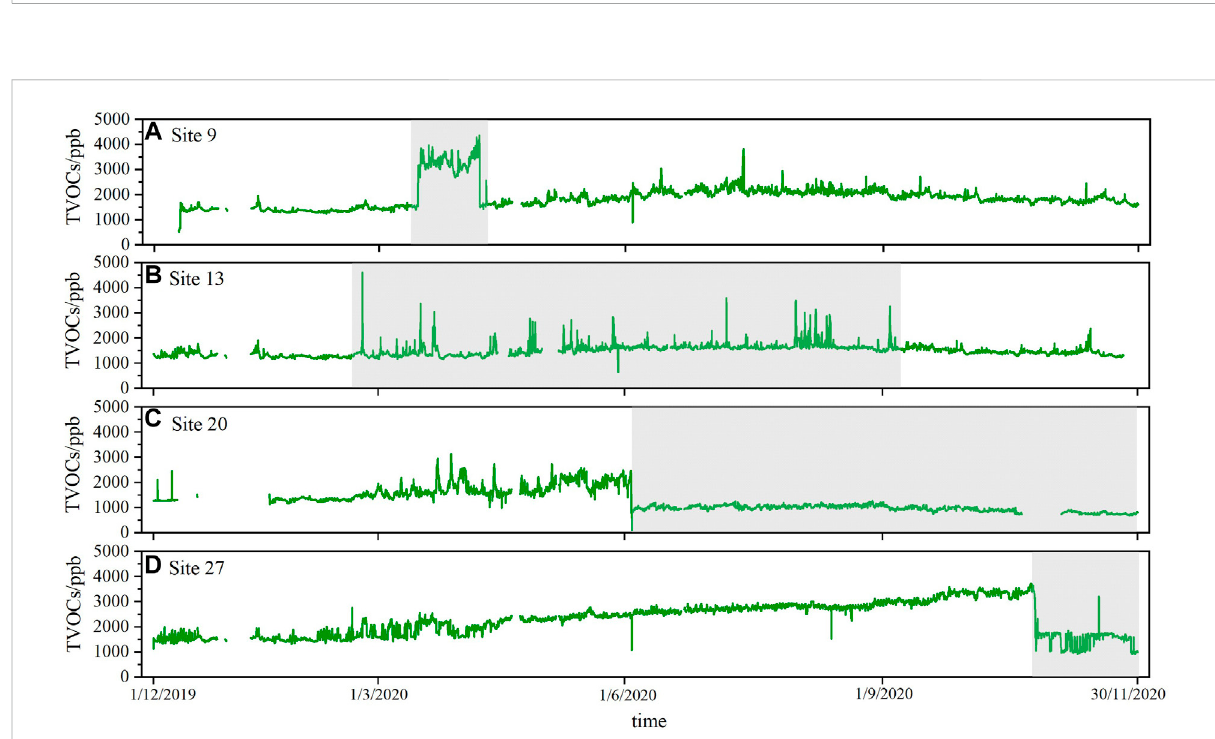
FIGURE 4 Temporalvariation of TVOCs atmonitoring stations ofsite 9 (A) ,site 13 (B) , site20 (C) andsite 27 (D) , TVOCsconcentrations showed atrend of sudden increase or decrease in a certain monitoring